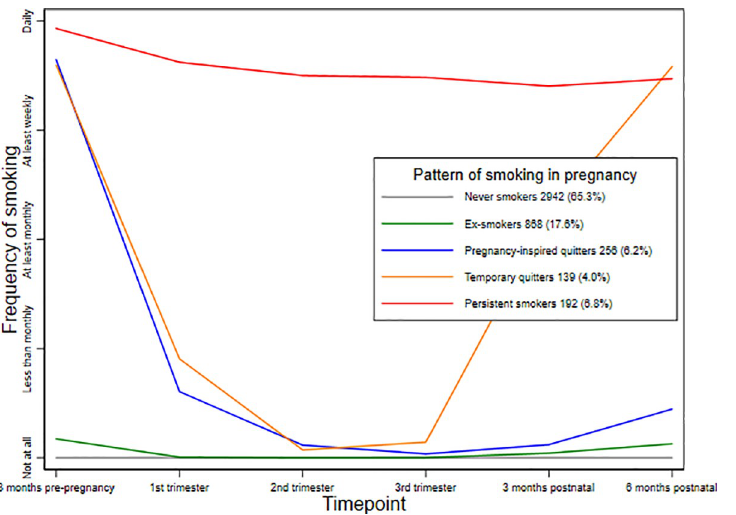
Fig 2. Latent class analysis of patterns of smoking frequency in